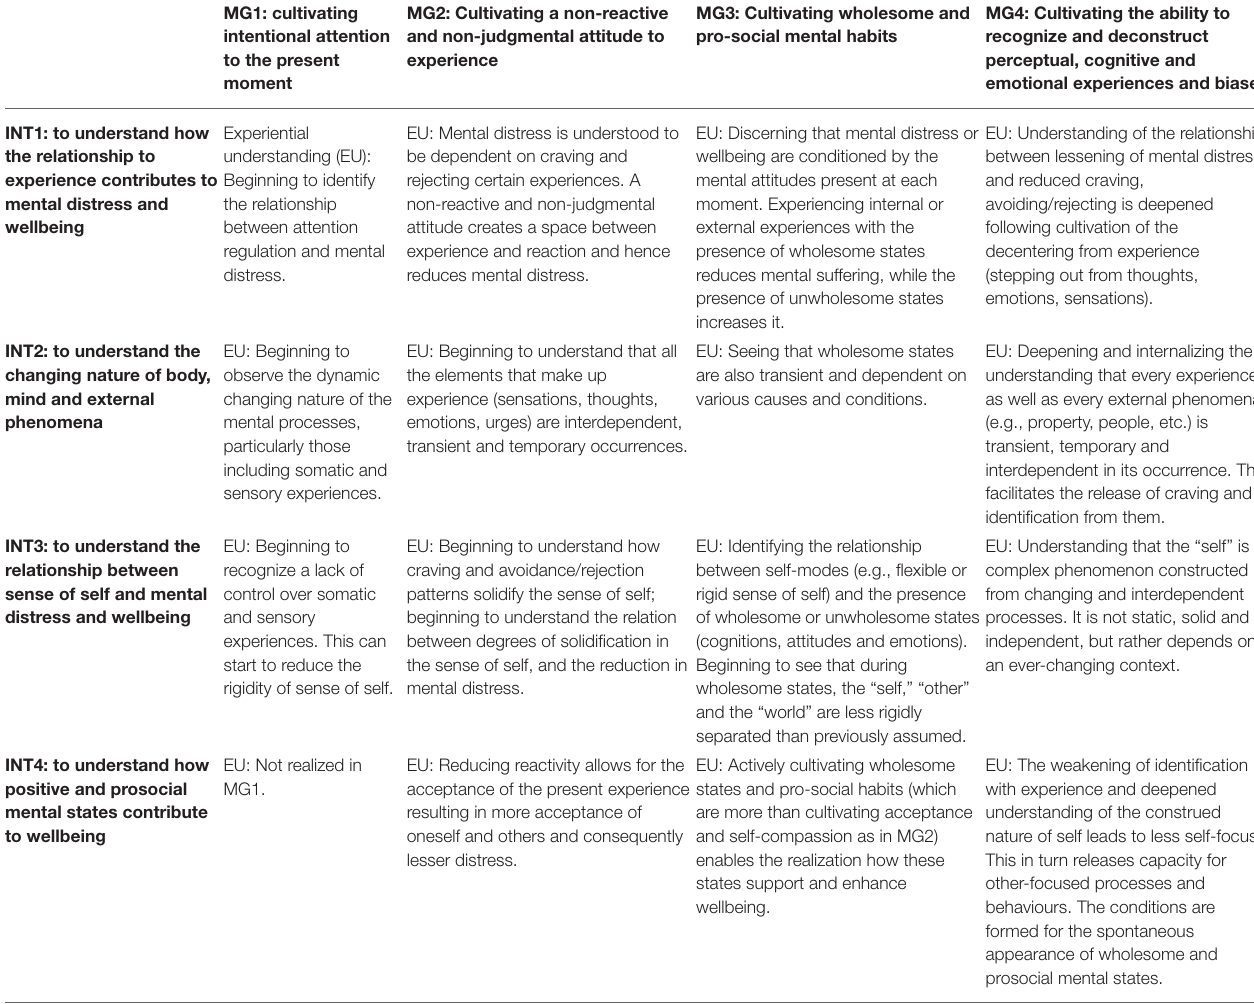
TABLE 1 | The Mindfulness Map.